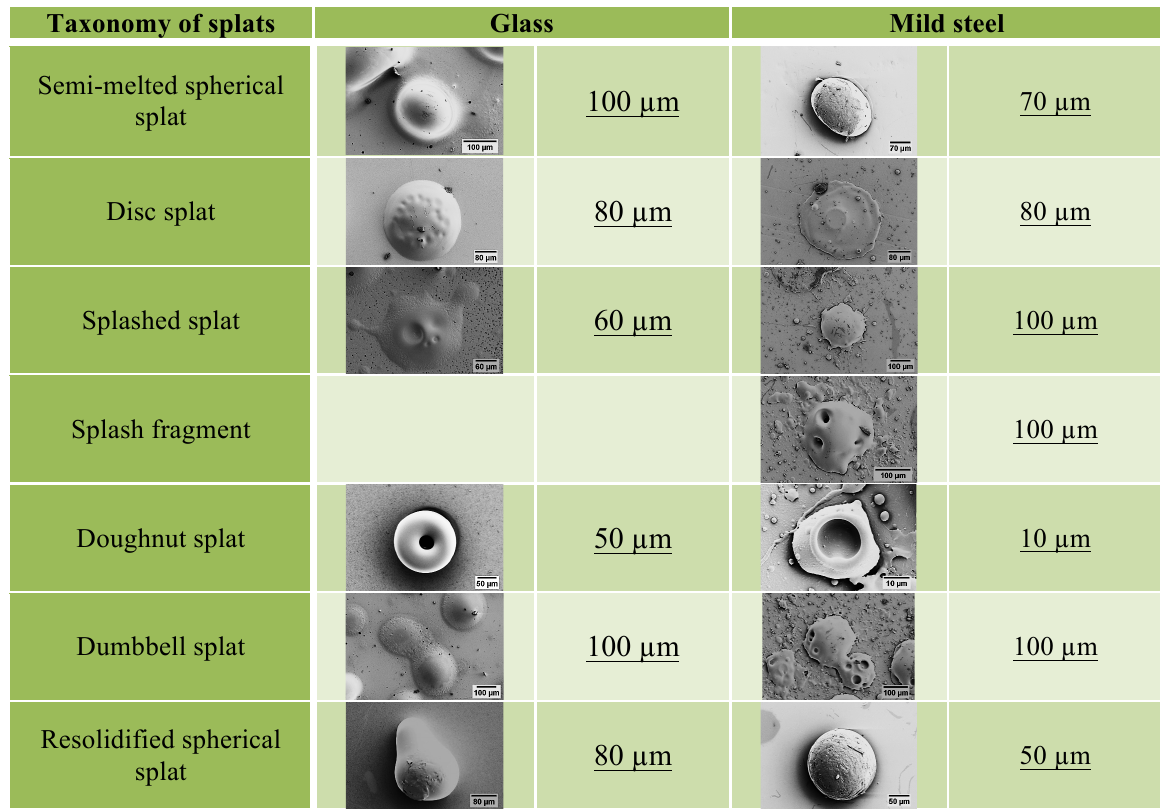
Table 2. Taxonomy of